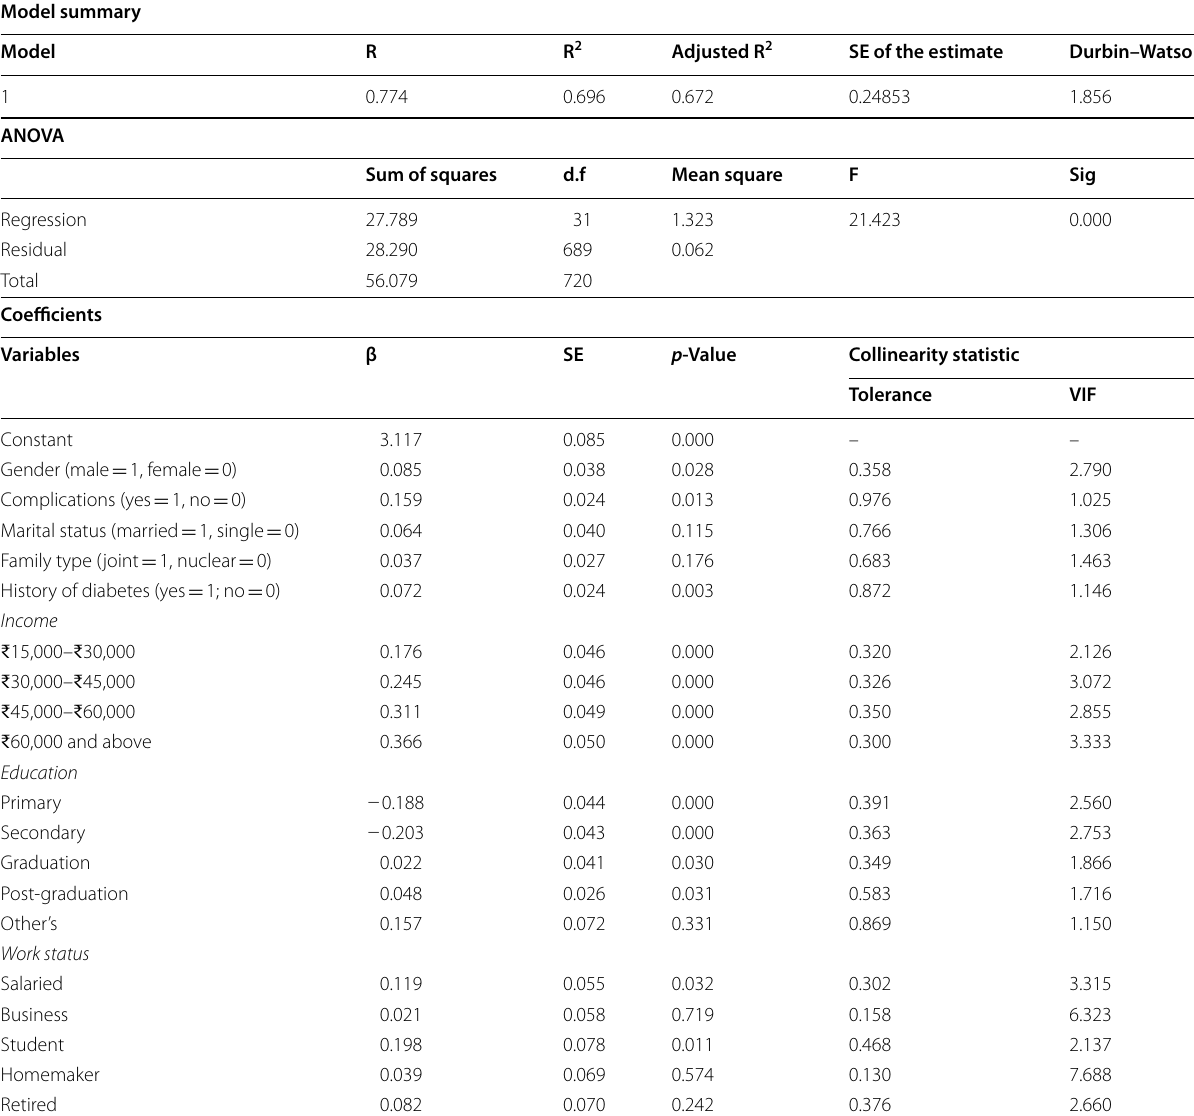
Table 5 Multiple linear regression analysis for determinants of total cost of diabetic patients in Punjab